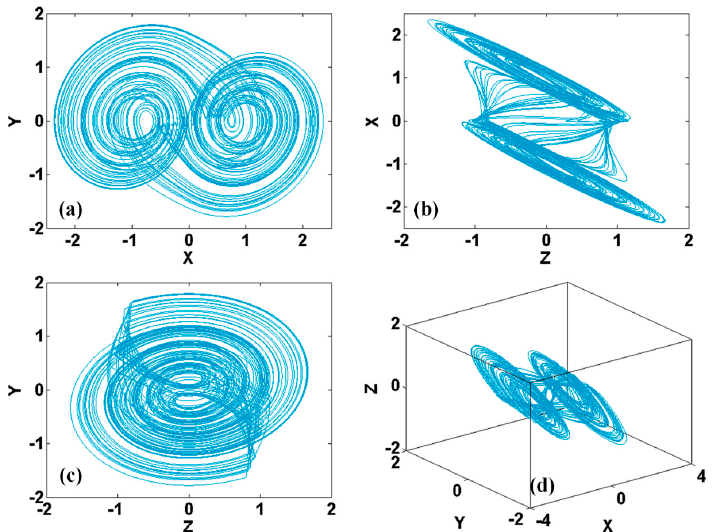
when a = 0.6, b = 1, and ( x 1 , y 1 , z 1 ) = (0, 0, 1), the system (1) is in a chaotic orbit, as shown in Figure 2.